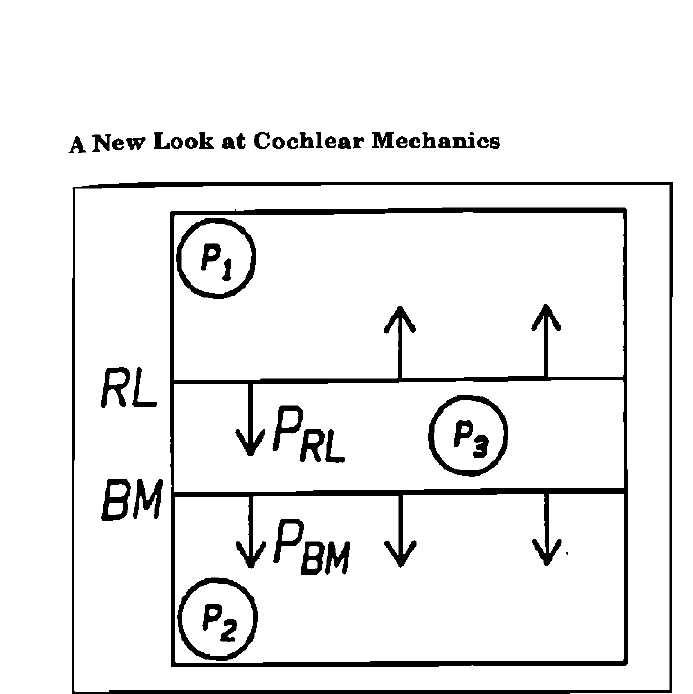
Figure 3. The "Sandwich Model" showing a filling of scala media (P3) with the organ of Corti, and two wedges on either side, the scala vestibuli (P2) and tympani (PI) (after de Boer, 1990,